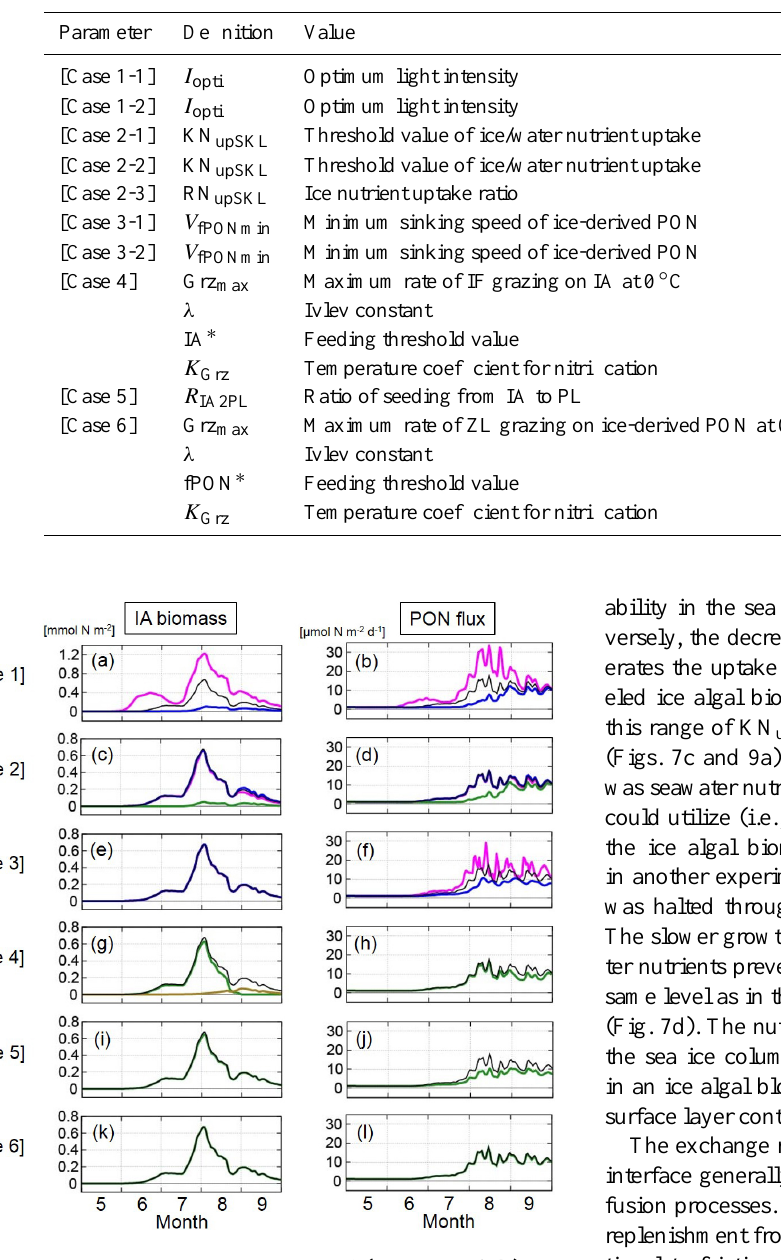
Figure 14. Modeled seasonal transition of (a, c, e, g, i, k) ice algal biomass (mmol Nm − 2 ) and (b, d, f, h, j, l) PON flux (µmolNm − 2 d − 1 ) in the NAP region in (a–b) Case 1, (c–d) Case 2, (e–f) Case 3, (g–h) Case 4, (i–j) Case 5, and (k–l) Case 6. Black thin lines correspond to the original 2011 case. The results with I opti of 5 (20) Wm − 2 in Case 1, KN upSKL of 0.5 (1.5)mmolNm − 2 in Case 2, PON sinking speed of 200 (20)md − 1 in Case 3 are shown by magenta (blue) lines, respectively. The uptake formulation with- out sea ice nutrients results in a green line in Case 2. The biomass of ice-related fauna is shown by an olive line in Case